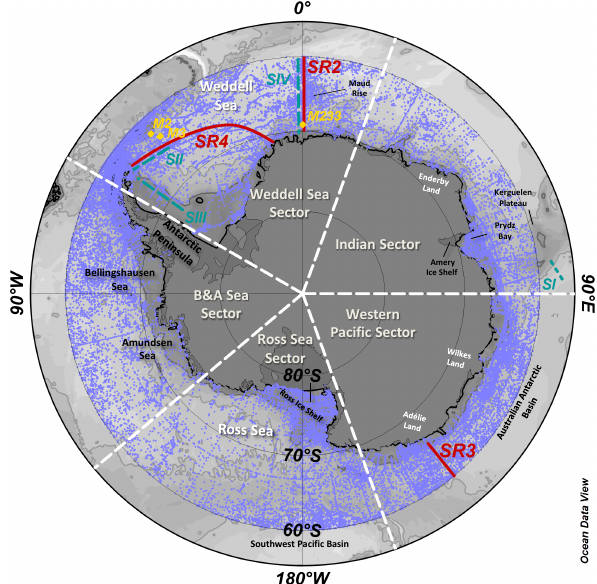
Figure 1. Map indicating the geographic areas of oceanographic profiles (blue dots), hydrographic sections, and mooring positions used in this study. Mooring positions from Klatt et al. (2005) (M233) and Gordon et al. (2010) (M2 and M3) are indicated by yellow diamonds. Sections where volume transport was determined (Section I – SI, Section II – SII, Section III – SIII, and Section IV – SIV) are indicated by green dashed lines. Red lines denote the repeat WOCE hydrographic sections used in this study (sampling periods are presented in Table S1 – see Supplement). Dark and light gray lines refer to the bathymetry of 1300 and 4000m, respectively. The radiating white boundary lines delineate hydrographic sectors. B&A denotes the Bellingshausen and Amundsen Sea